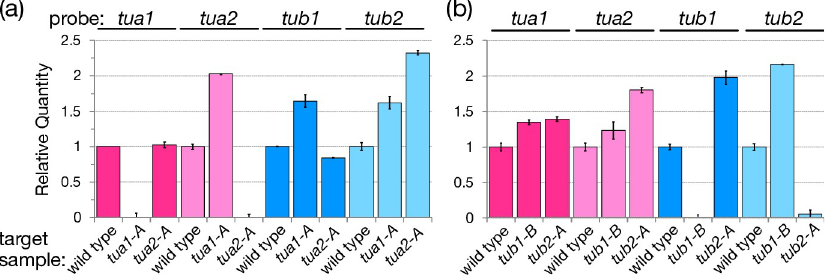
Fig 2. Semi-quantitative real-time polymerase chain reaction in the tubulin-gene disruptants. The transcription levels of the four tubulin genes were analyzed by using total RNA extracted from (a) wild type (CC-125) and two α - tubulin gene disruptants ( tua1-A and tua2-A ), and (b) from wild type and two β -tubulin gene disruptants ( tub1-B and tub2-A ). Data are means ± SD (n =